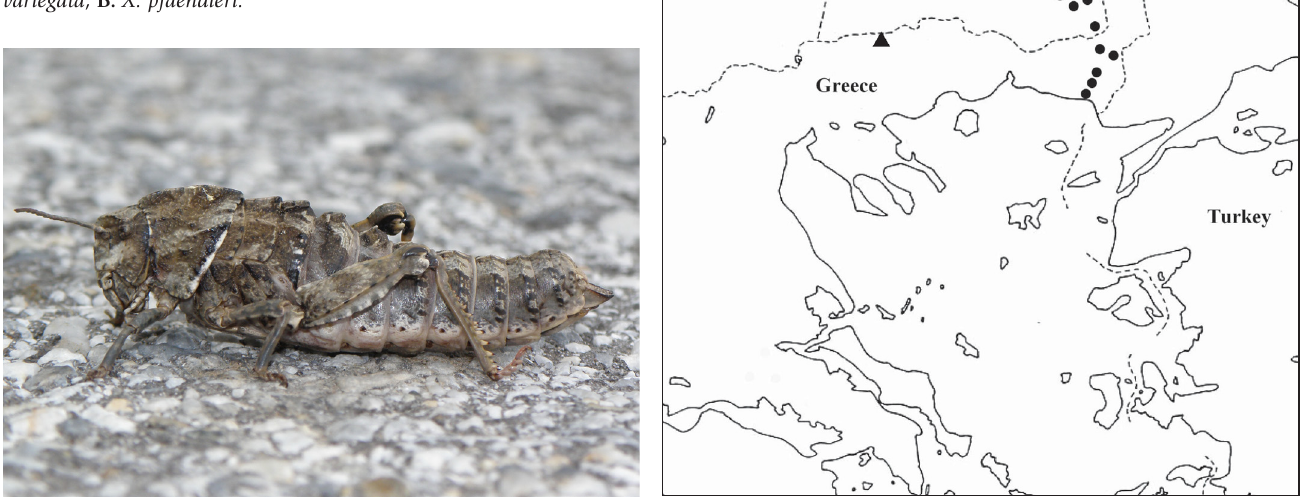
Figure 16. Total known distribution of Paranocarodes chopardi (• literature records, ▲ new